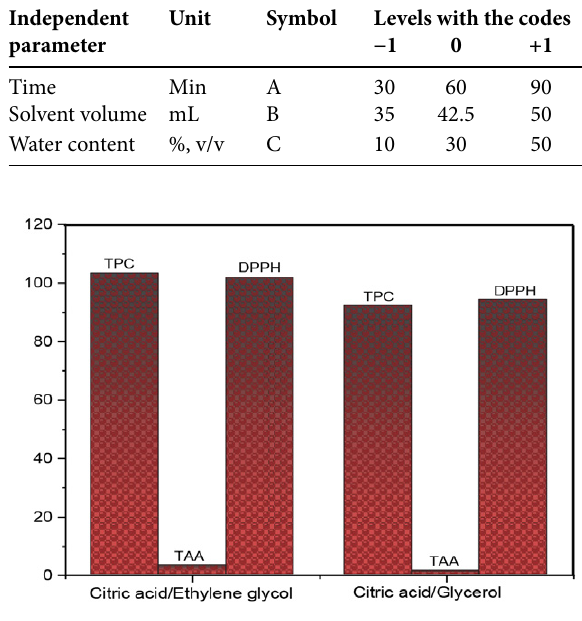
Figure 2. Comparative results of the selected DES on the perfor- mance of UAE of Rosa canina L. fruits